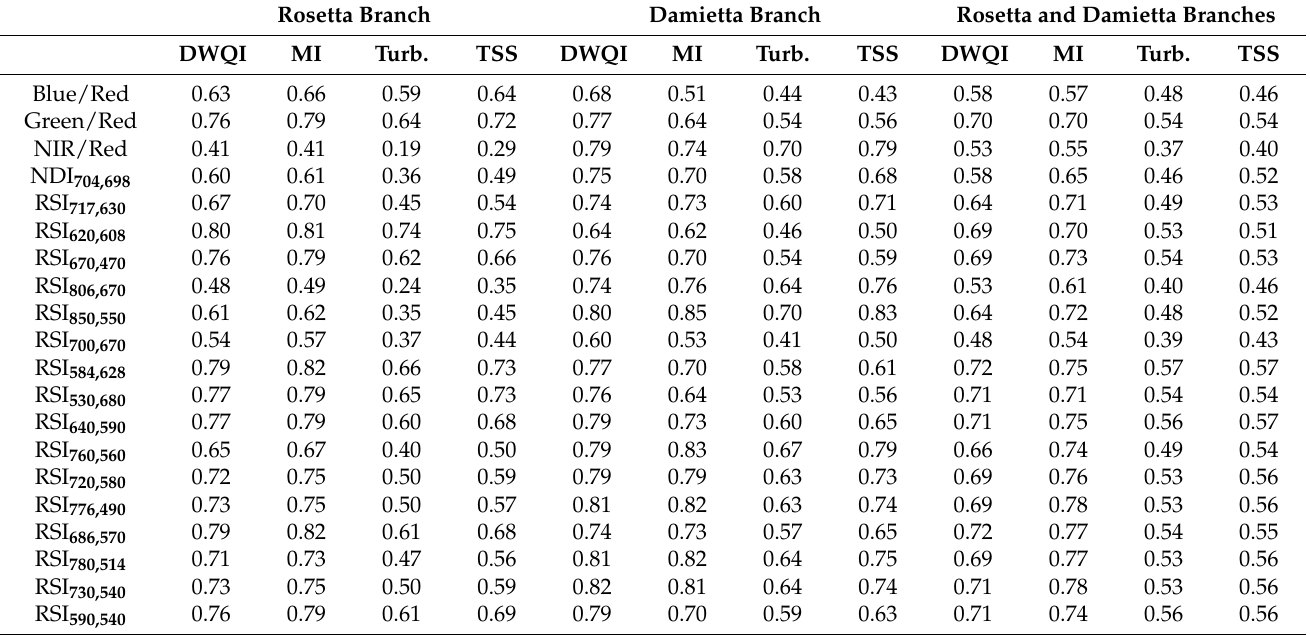
Table 7. R 2 for the linear association between SRIs and drinking water quality index (DWQI),